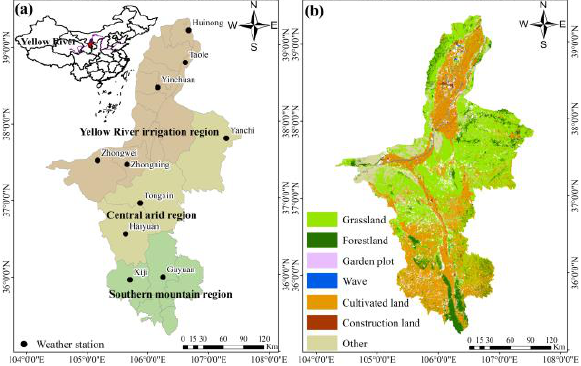
Figure 1. Location (a) and the types of vegetation cover (b) of the study area Figure 2. Distribution of simulated weather station Specific process: based on the geostatistical analysis of the actual measurement stations in Ningxia, the result shows that 30km is a suitable sampling area. Then, we draw circular influence areas with a radius of 30km in the non-meteorological site